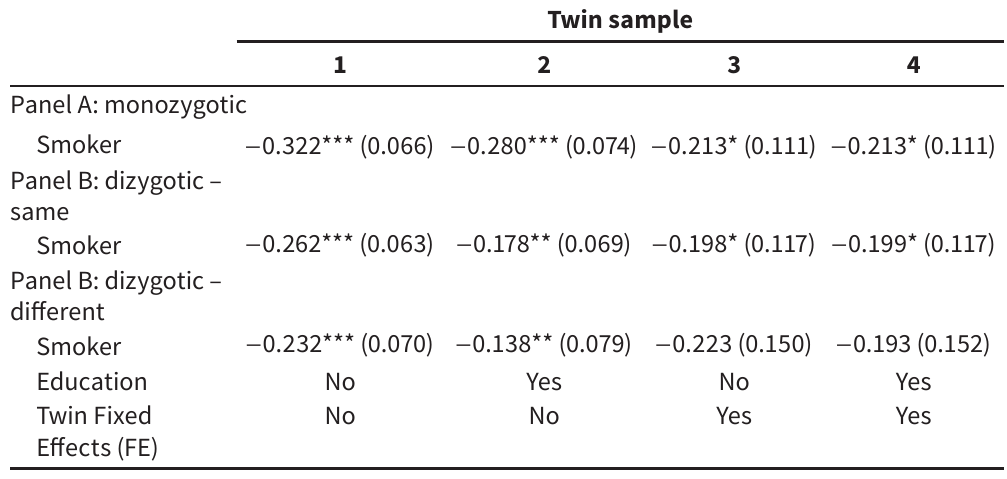
The effect of smoking on earnings by zygosity